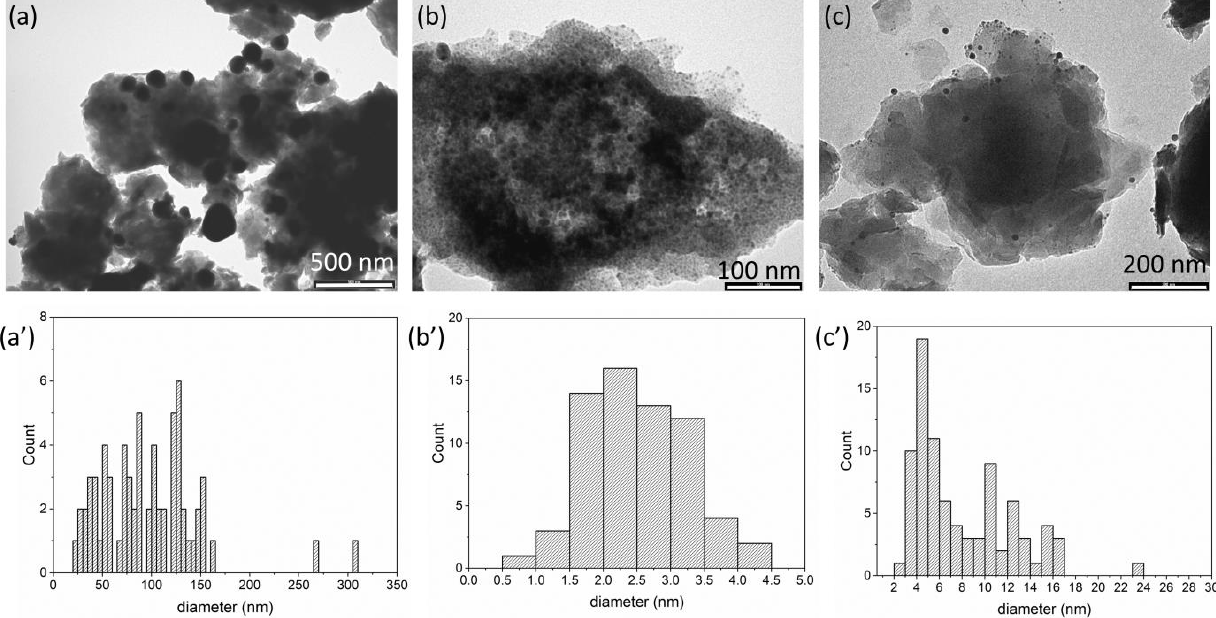
Figure 5. TEM images and size distribution profile of silver NPs of: Ag/ZnAl-Ac ( a , a’ ); Ag/ZnAl-CFZ ( b , b’ ); Ag/ZnAl-NAL ( c , c’ ).